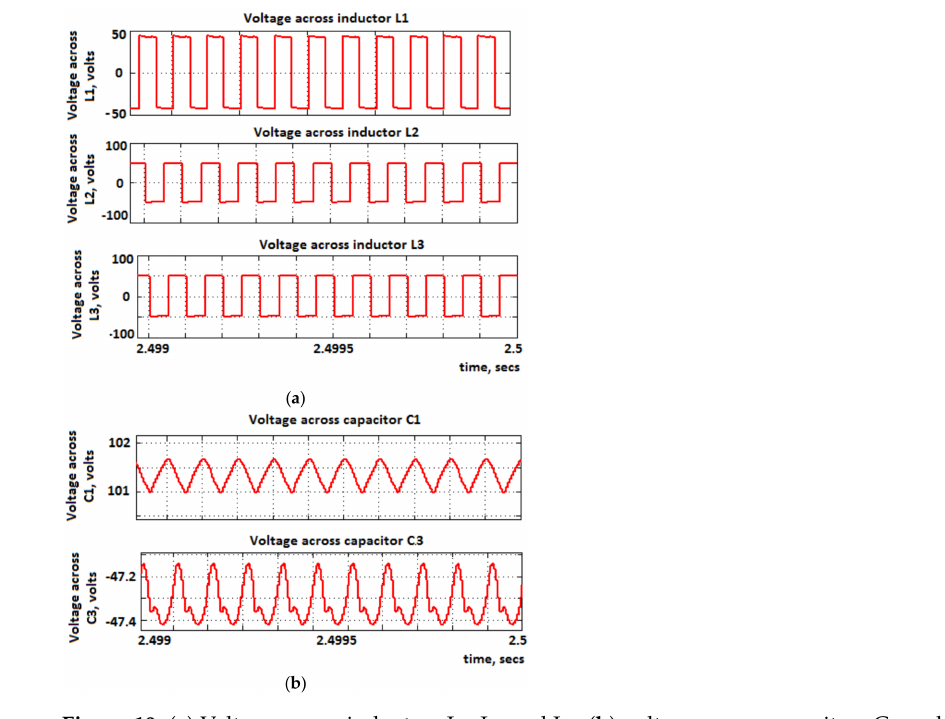
Figure 10. ( a ) Voltage across inductors L 1, L 2 and L 3 ; ( b ) voltage across capacitors C 1 and C 3 .